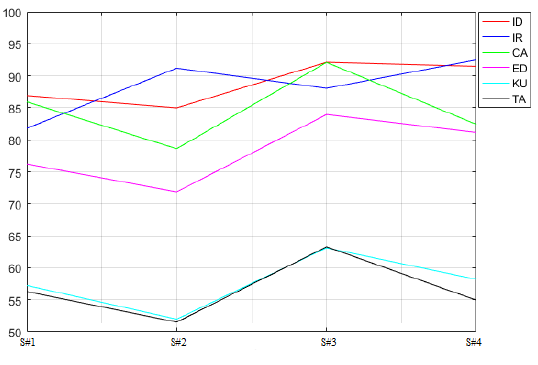
Figure 10. Trend of OA for CD methods in Data